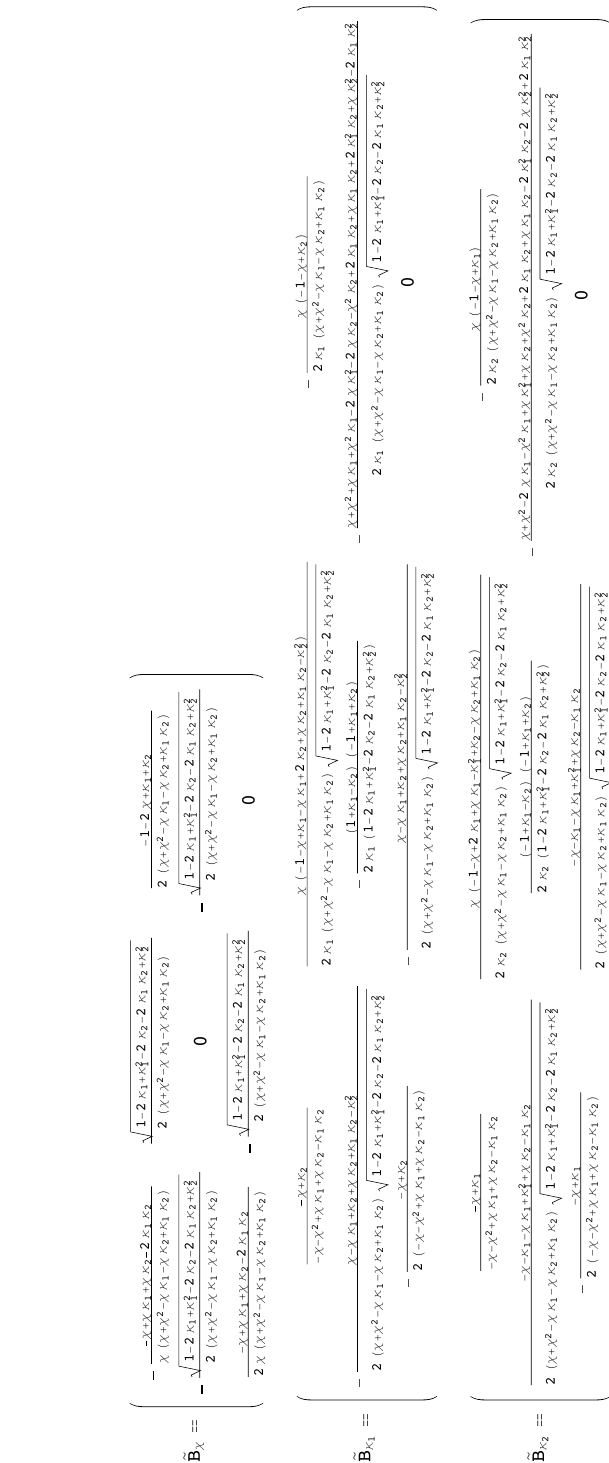
Figure 10 . Matrices for the di(cid:11)erential equa- tions on the maximal cut for the double box with two adjacent massive legs.